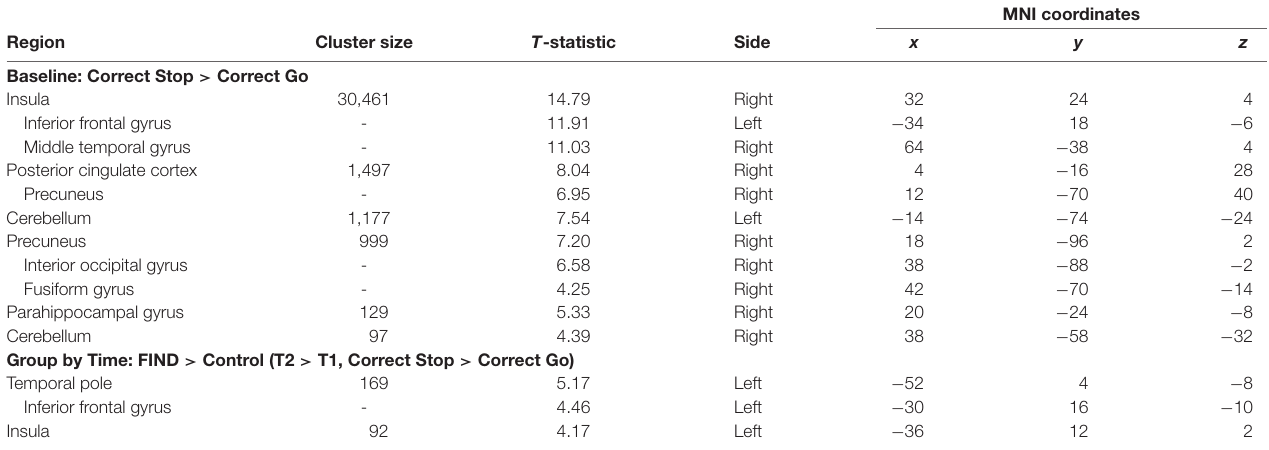
TABLE 3 | Peak voxel and maximum T -values for SST baseline and group by time effects.